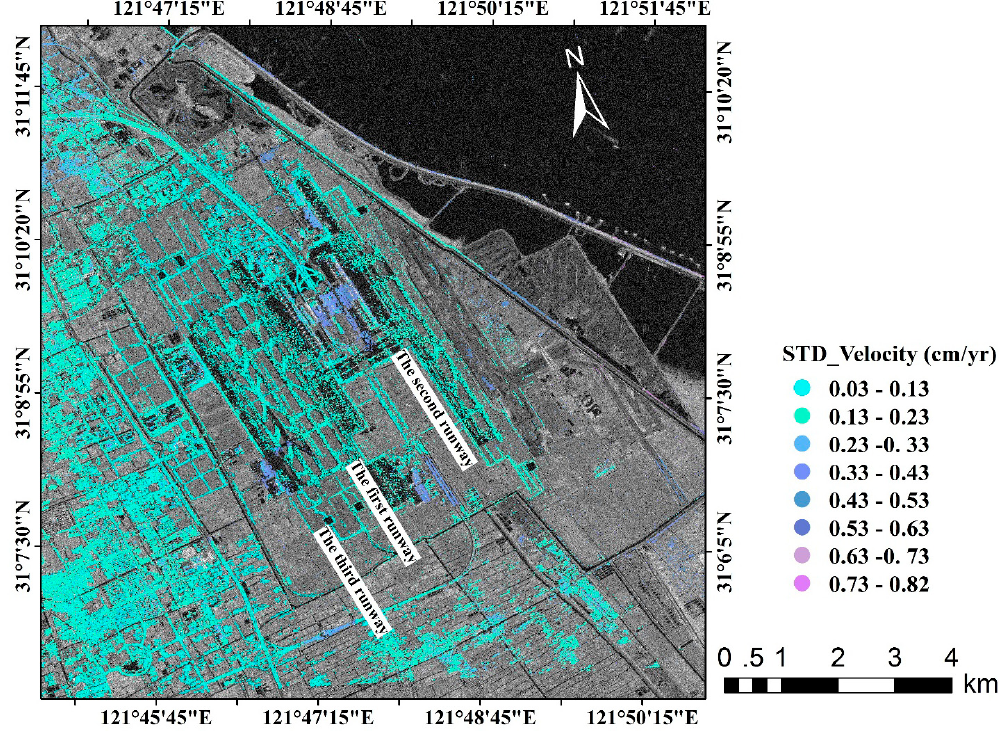
Figure 6. The standard deviation of the mean velocity on coherent point targets.